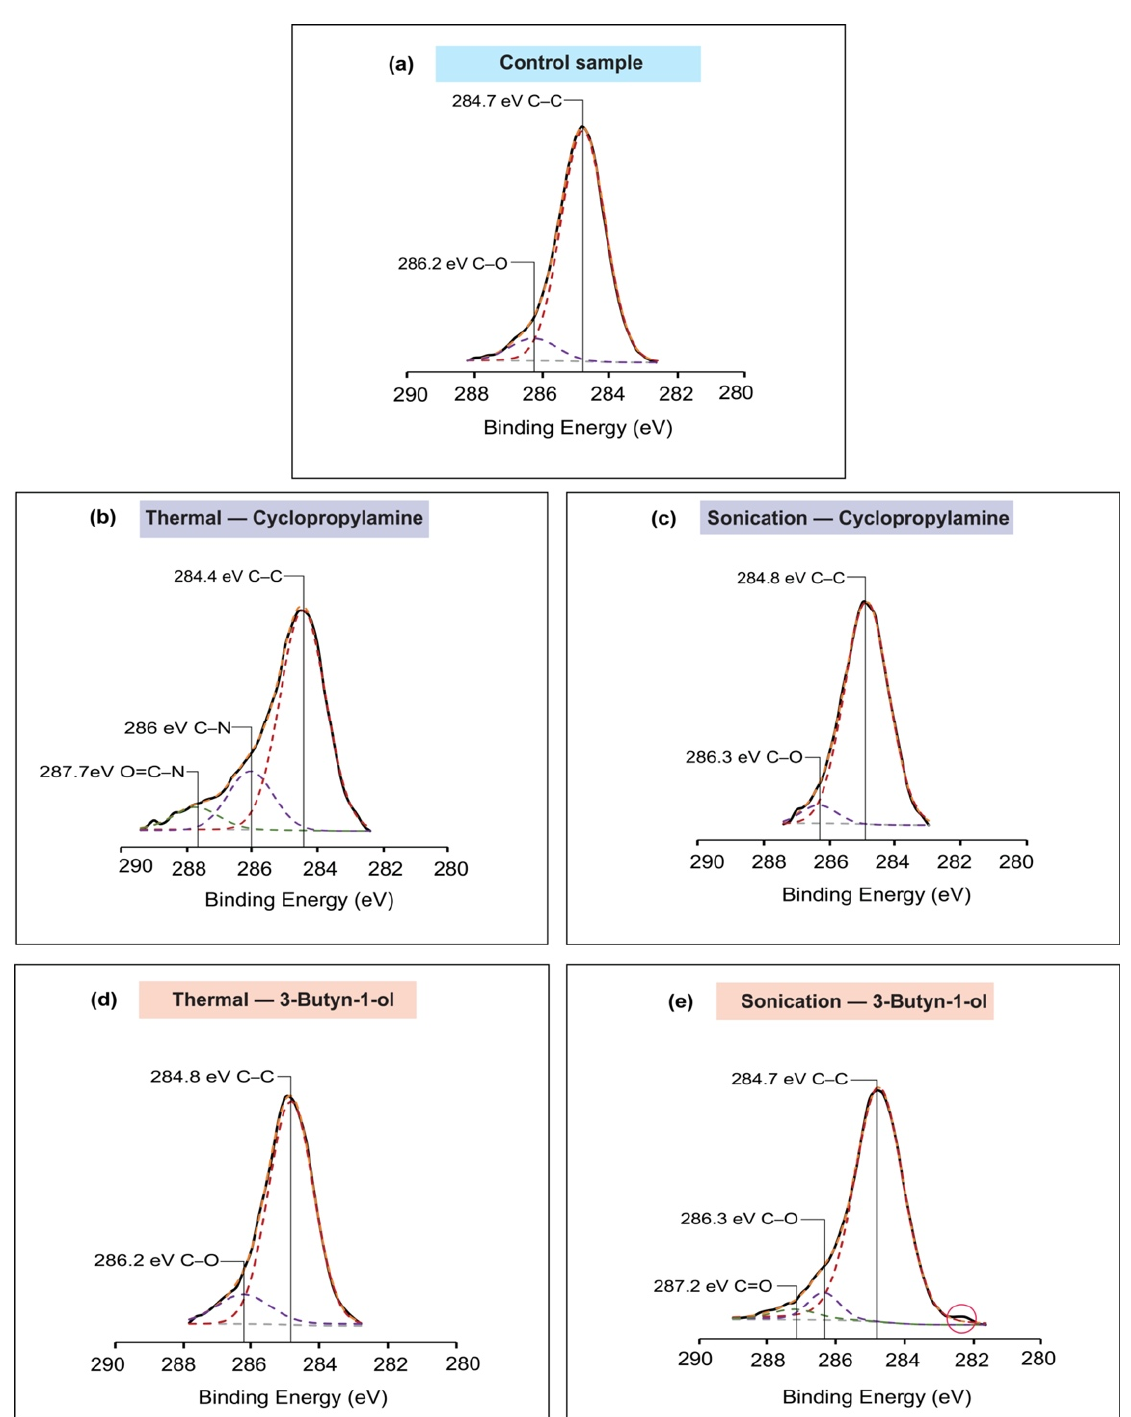
Figure 3. The analysis of the C1s spectra of each sample. ( a ) Control sample; ( b ) cyclopropylamine thermal reaction with C–N and O=C–N linkage type; ( c ) cyclopropylamine sonochemical reaction; ( d ) 3-Butyn-1-ol thermal excitation; ( e ) 3-Butyn-1-ol sonochemical reaction with carbon–carbon and carbon–oxygen peaks. The outlined part suggested that the reaction may have occurred.